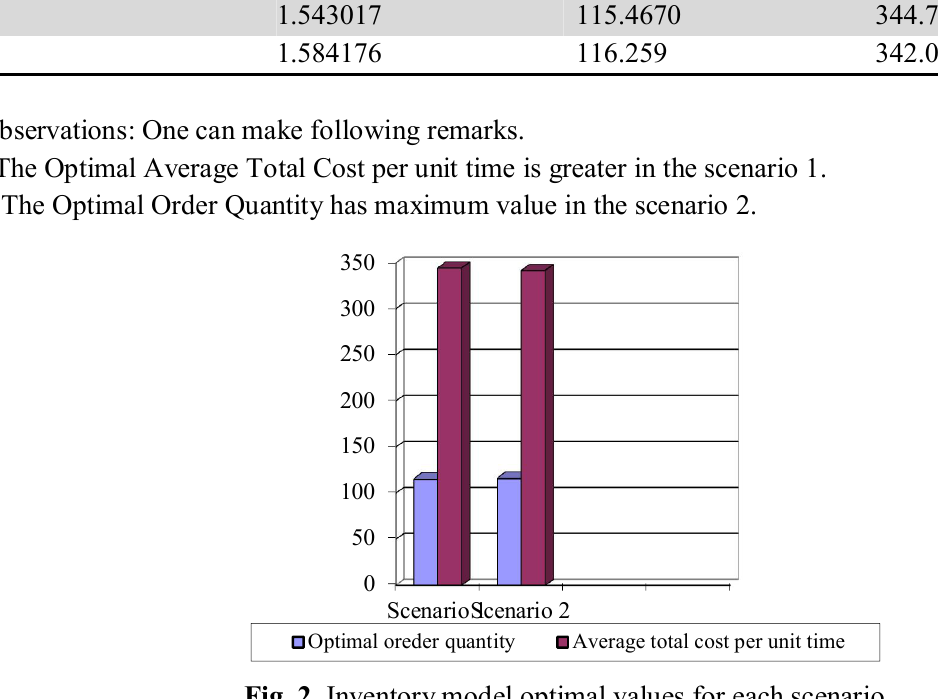
Fig. 2. Inventory model optimal values for each